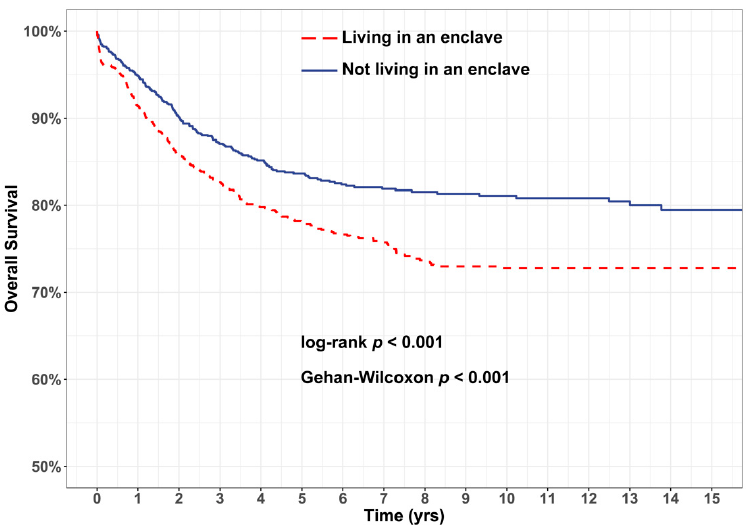
Figure 3. Kaplan–Meier analysis indicates Hispanic children living in enclaves have poorer overall survival than Hispanic children not living in enclaves. Significant survival disparities were observed for Hispanic children living in enclaves at the time of their diagnosis (red), relative to Hispanic children not living in enclaves (blue).